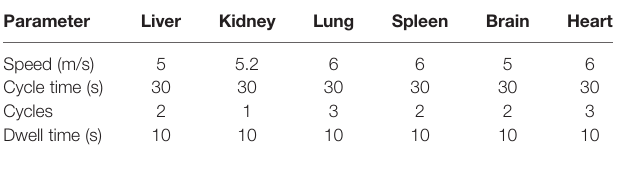
TABLE 1 | Homogenization parameters for organ experiments.